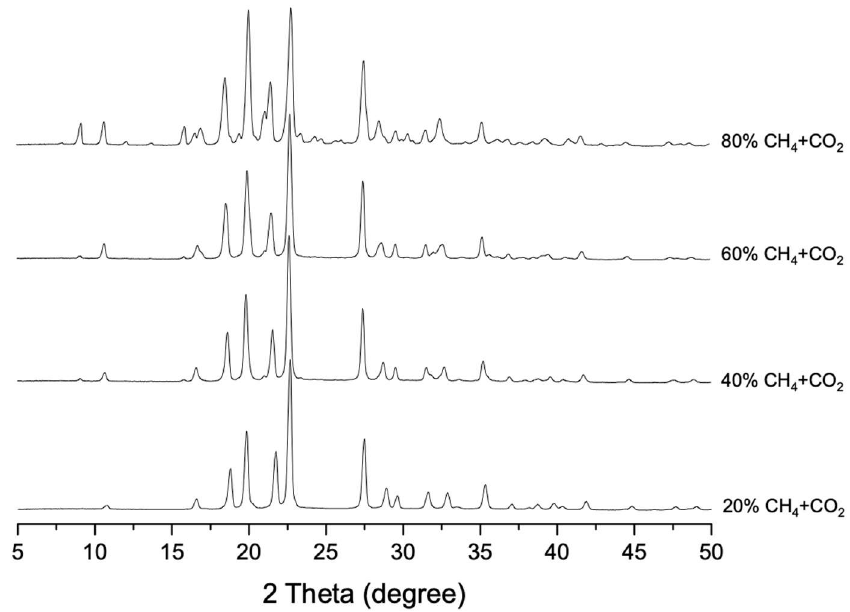
Figure 3. Powder XRD patterns for the HQ samples after reactions with binary (CH 4 + CO 2 ) gas mixtures of various compositions at 20 bar.